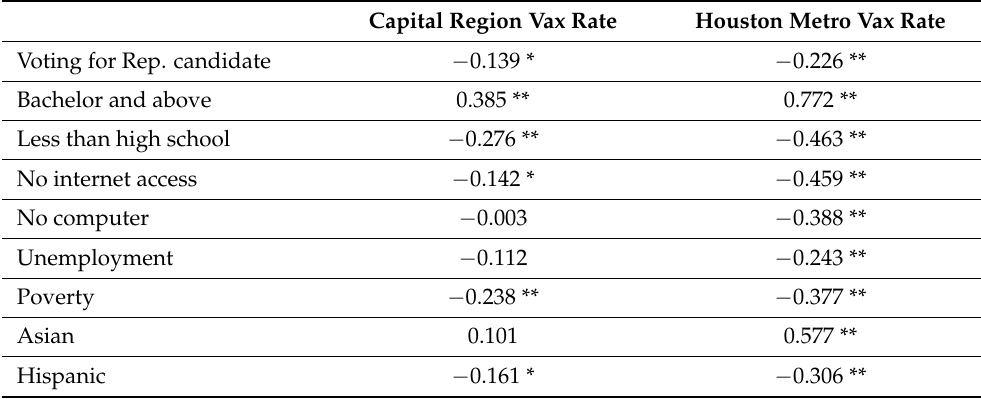
Table 2. Pearson’s correlation between vaccination rate and other significant factors. Capital Region Vax Rate Houston Metro Vax Rate Voting for Rep.